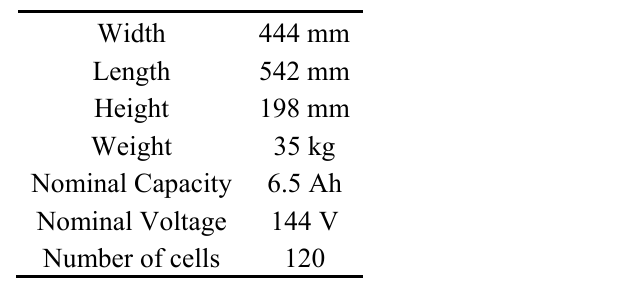
Table 6. Dimensions and main electrical specifications of the improved pack